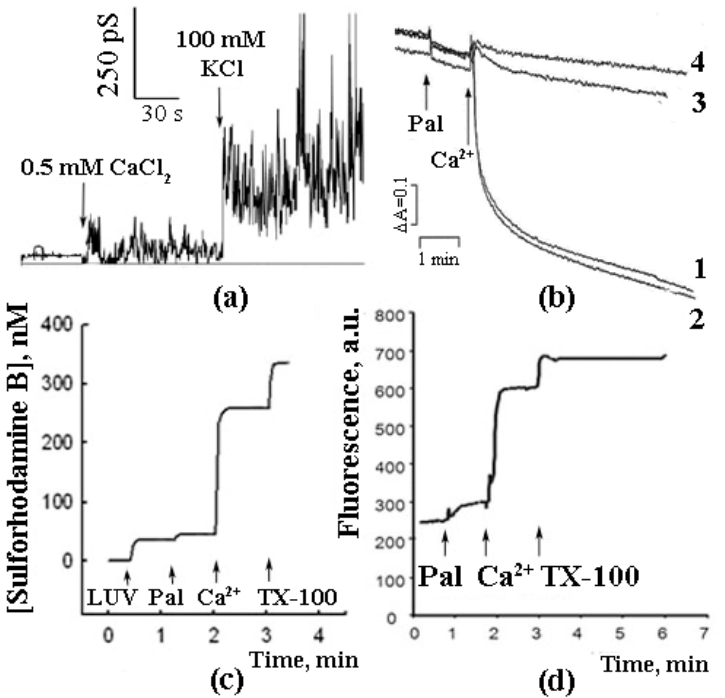
Figure 1. Palmitic acid can induce Ca 2+ -dependent permeabilization of artificial and biological membranes. ( a ) Planar lipid bilayer, PA 0.5%, membrane potential 100 mV. ( b ) Mitochondrial swelling: 1, 3, 4—no CSA, 2–1 µ M CSA. Additions: (1, 2) 15 µ M PA and 30 µ M Ca 2+ , (3) 15 µ M oleic acid (OA) and 30 µ M Ca 2+ , (4) 15 µ M brom-palmitic acid and 30 µ M Ca 2+ . ( c ) Artificial liposcheme 50 µ M PA and 1 mM Ca 2+ . ( d ) Plasmalemmal membranes of erythrocytes, release of the fluorescent probe sulforhodamine B from the erythrocytes induced by the addition of 50 µ M PA and 1 mM Ca 2+ . Typical curves are shown ( n = 6).